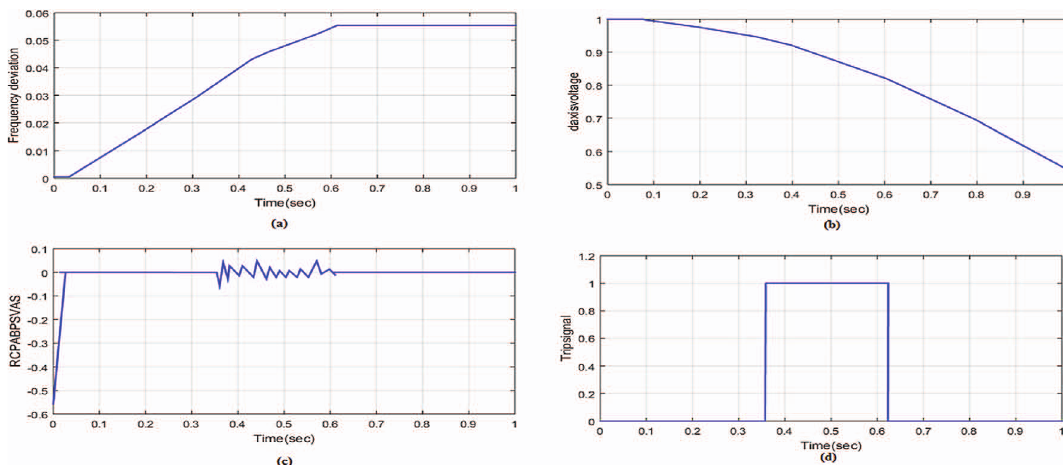
Fig. 15. System performance during capacitor switching, (a) frequency deviation versus time, (b) d -axis voltage versus time, (c) RCPABPSVAS versus time, and (d) trip signal versus